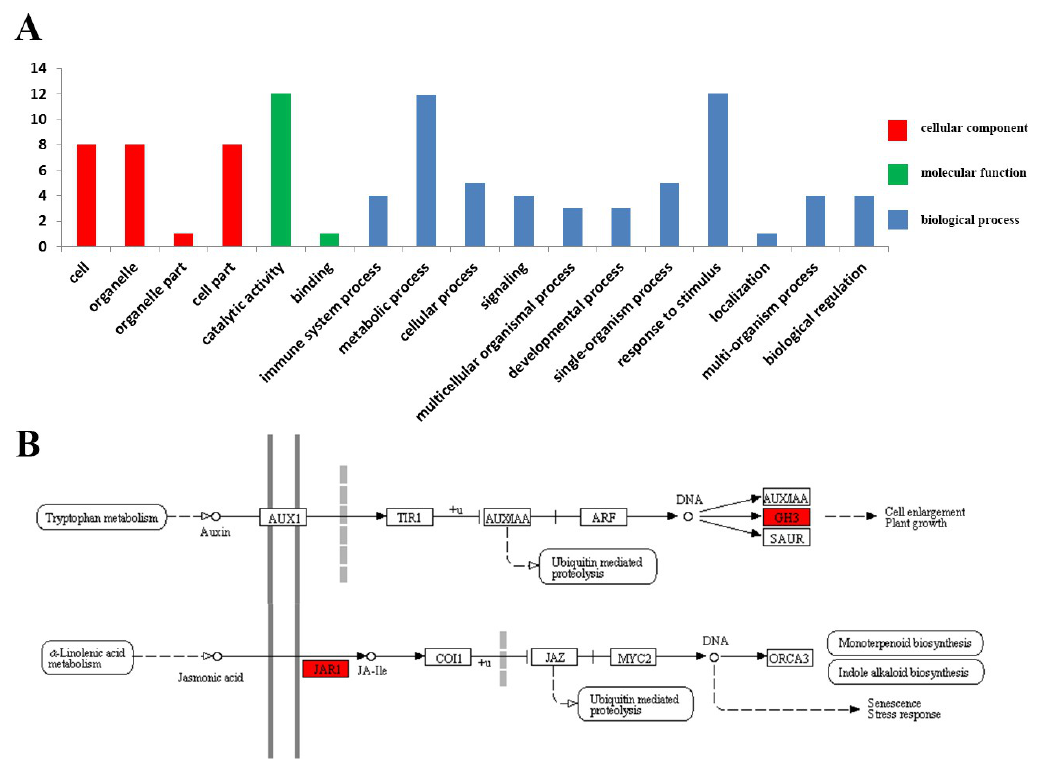
Figure 6. Gene ontology classification and KEGG pathway annotation of OsGH3 genes. ( A ) The Y-axis indicates the actual gene number and the X-axis indicates three categories (cellular component, molecular function, and biological process). ( B ) The OsGH3 -gene-related KEGG pathways are marked in red.